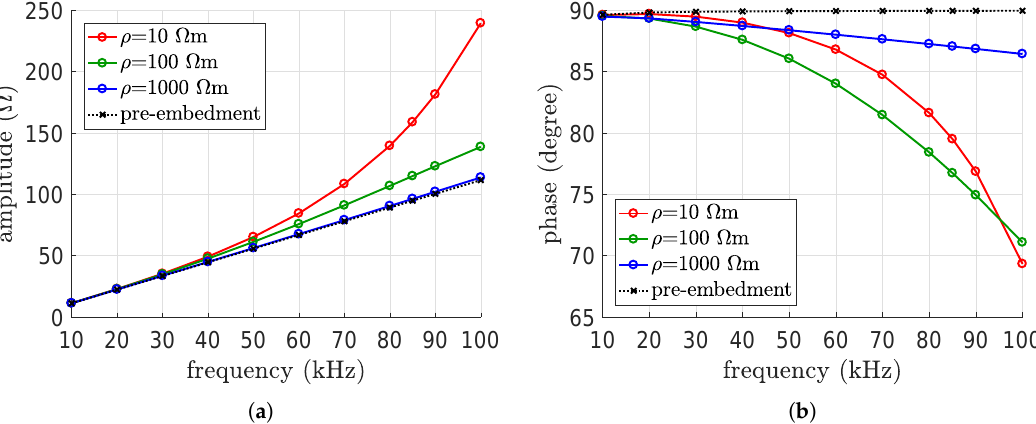
Figure 23. Equivalent impedance of the embedded coil ( Mod2 ) vs frequency parametrized for ρ equal to 10 Ω m, 100 Ω m, and 1000 Ω m. Amplitude ( a ); phase ( b ).